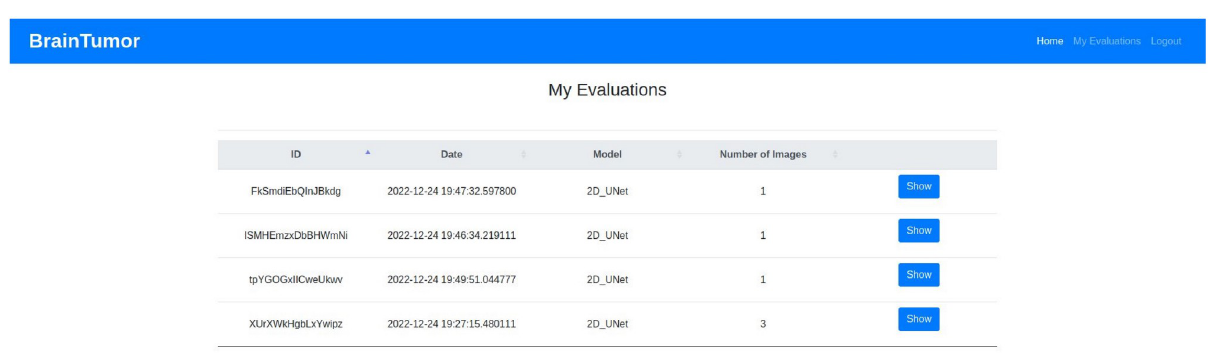
Fig 22. My evaluations page.